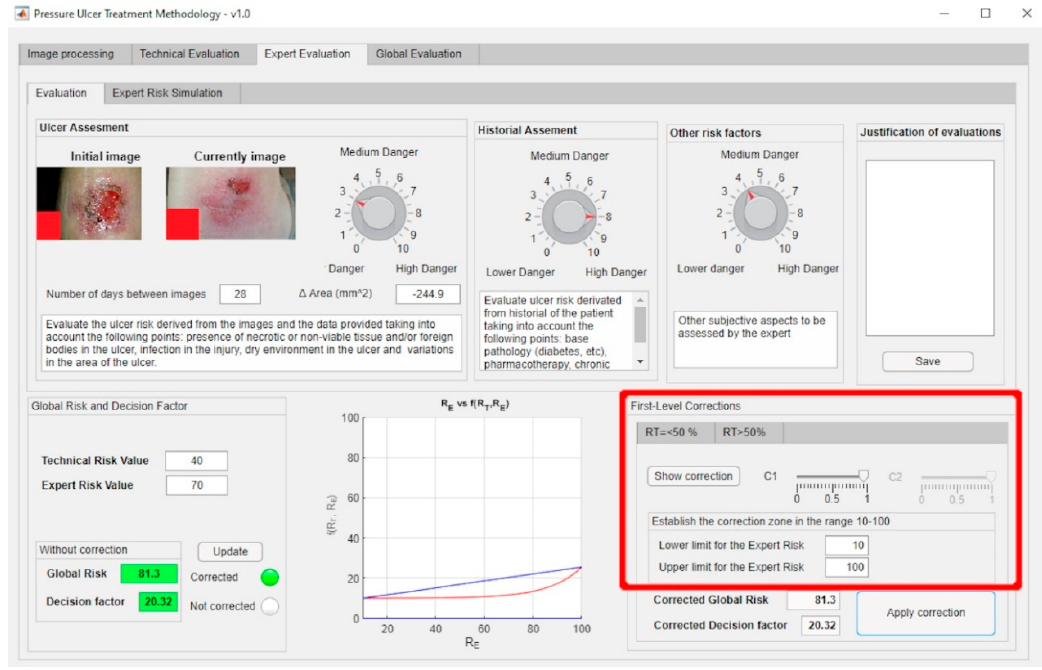
Figure 24. First-level correction.